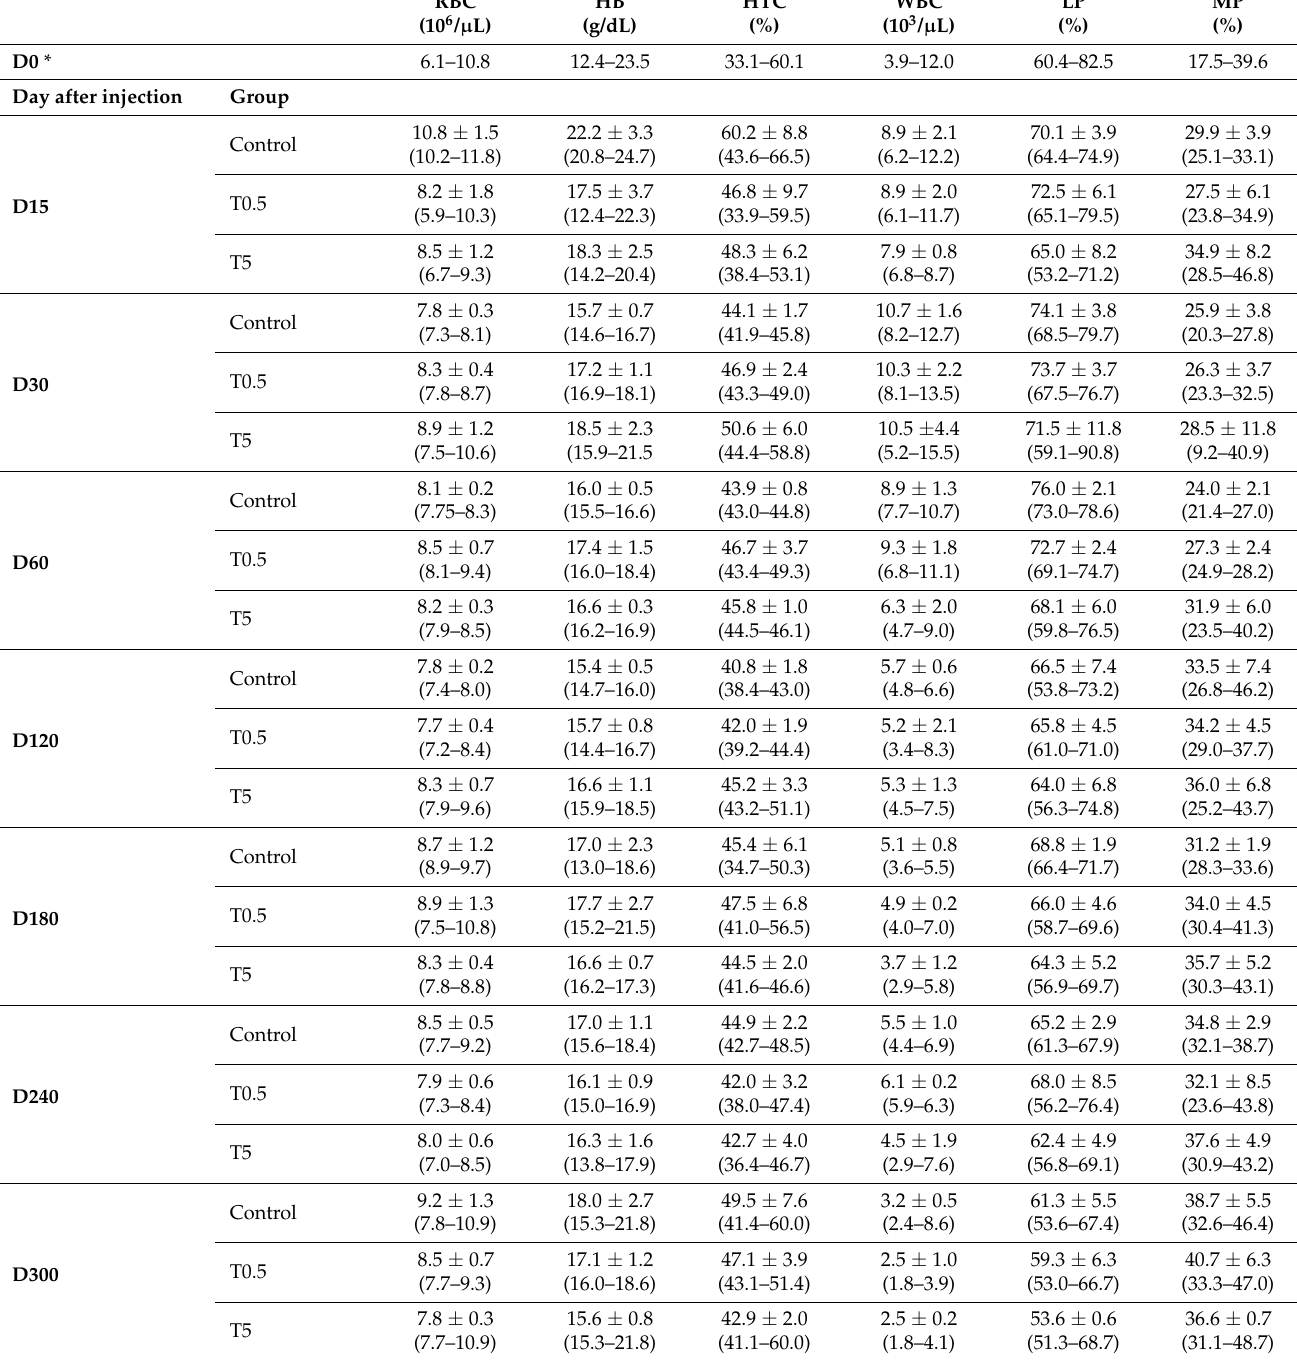
Table 1. Hematological data summary for control and treated animals. Complete data are provided in Supplementary Tables